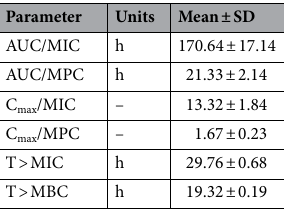
Table 4. PK/PD integration parameters for DAN in ileum ultrafiltrate after i.m. administration at a dose of 2.5 mg/kg. (n =